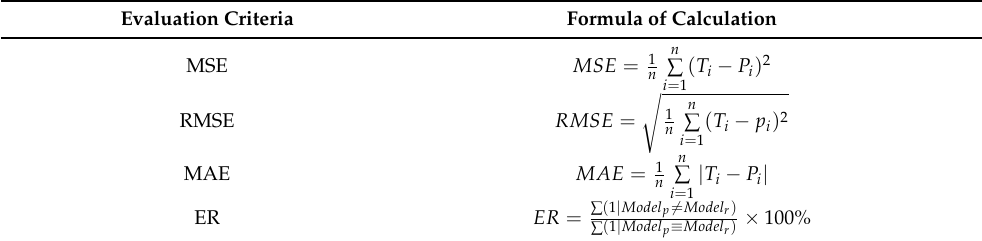
Table 4. Model evaluation